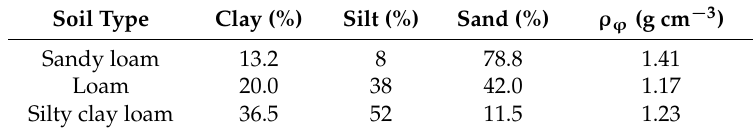
Table 1. Soil particle size distribution and bulk density, ρ ϕ , of the soils